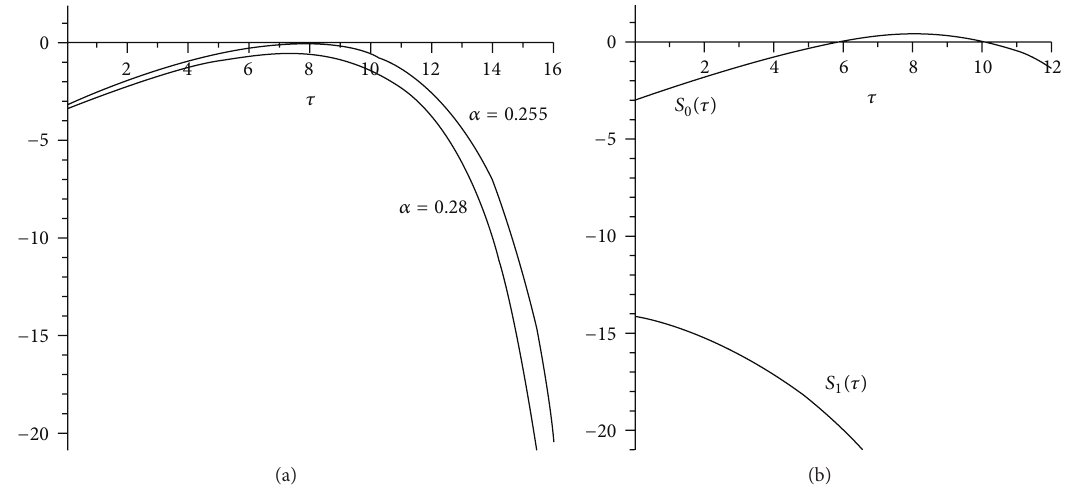
Figure 2: (a) Graph of 𝑆 0 for 𝛼 = 0.28 and 𝛼 = 𝛼 tr : no stability switch occurs; (b) graph of stability switch in terms of time delay if 𝛼 = 0.23